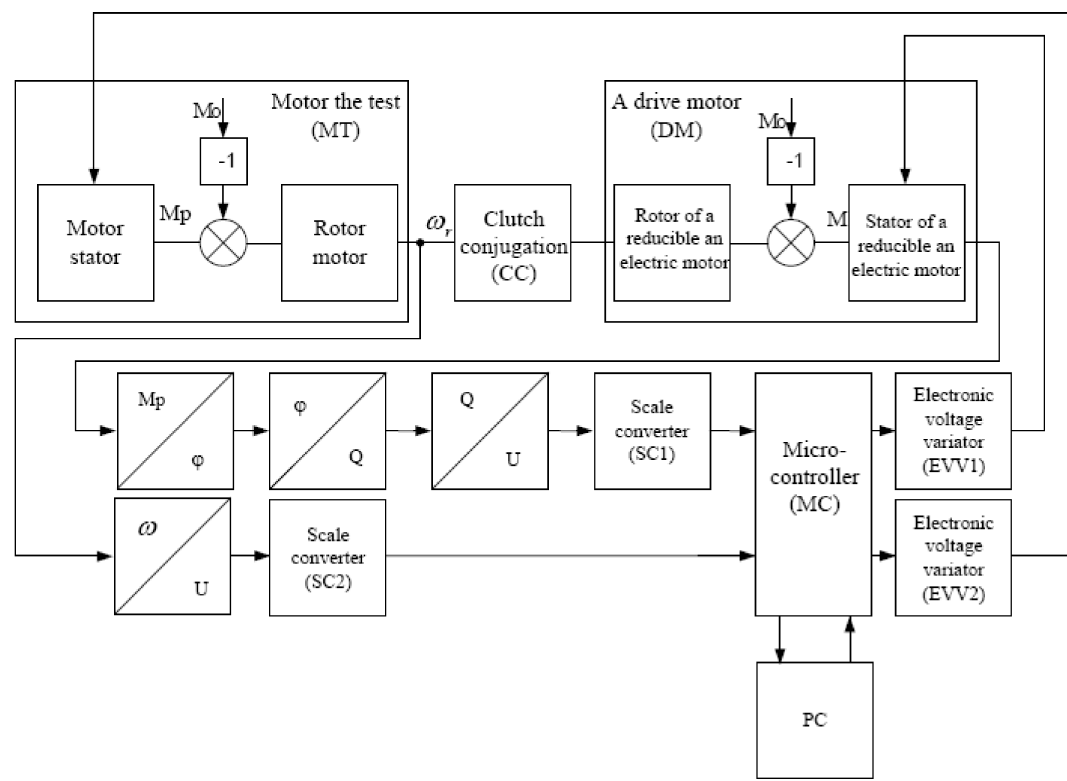
Fig. 1. Block diagram of the torque